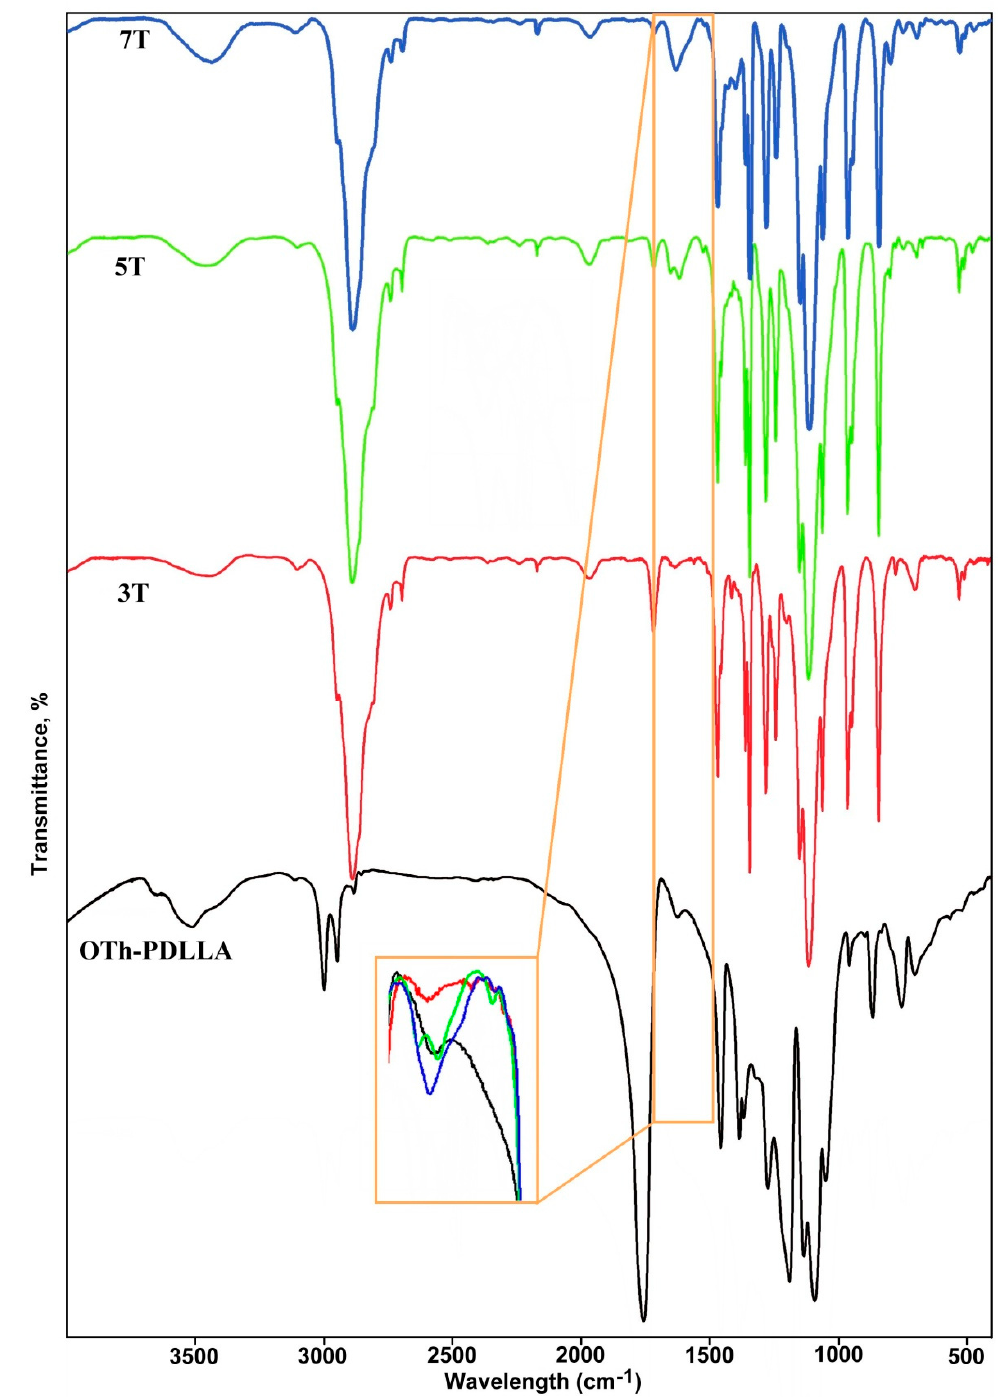
Figure 5. FT–IR spectra of PEG 2000 -substituted thiophene oligomers containing 3 ( 3T ), 5 ( 5T ), or 7 ( 7T ) thiophene rings and the spectrum of OTh-PDLLA .